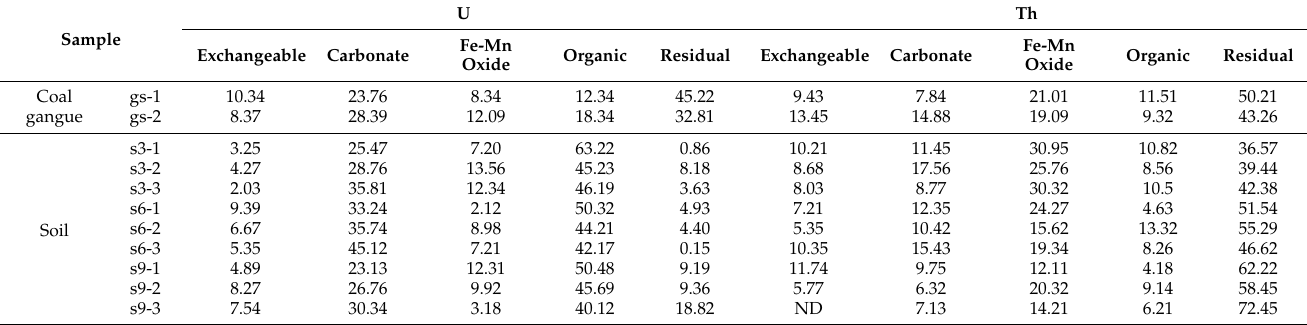
Table 3. The modes of occurrence for U and Th elements in coal gangue and soil profile samples (Unit: Bq/kg). Sample